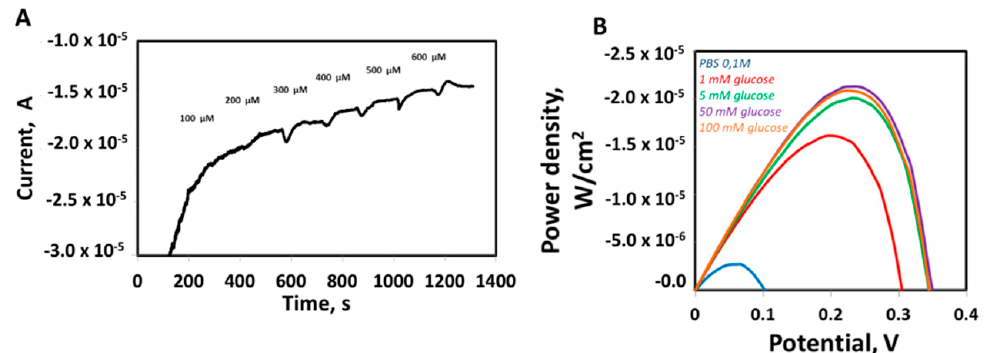
Figure 6. Enzyme-modified CH-CB membrane performance in sensing and energy harvesting applications. ( A ) Amperometry at − 0.45 V for glucose detection in the presence of O 2 using a CH-CB electrode modified with the GOx. Inset: calibration plot, linear range (100–600 µM). ( B ) Glucose BFC power density (GOx-based anode and Laccase-based cathode) in PBS 0.1M (blue) with different glucose concentrations: 1 mM (red), 5 mM (green), 50 mM (purple), 100 mM (orange).